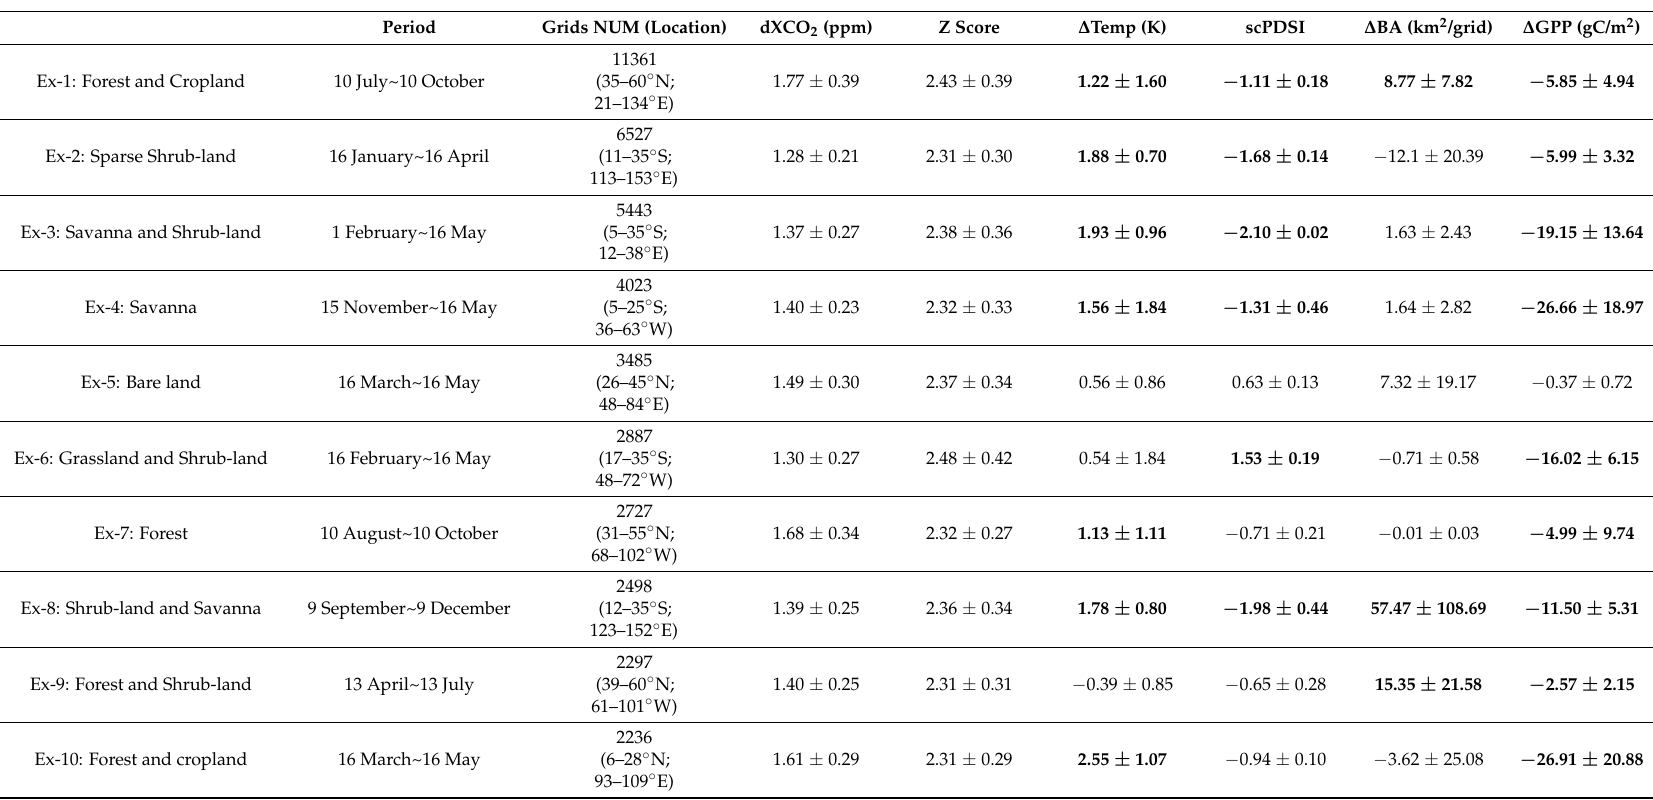
Table 2. Time and space features of detected extreme units (Ex) 1 through 10. Their land over types, period, grids number (NUM), location, dXCO 2 , Z score, and difference between monthly data and its normal value over significant different period about surface skin temperature ( ∆ Temp), self-calibrating Palmer drought severity index (scPDSI) (negative for drought and vice versa), burned area ( ∆ BA) and gross primary production ( ∆ GPP) during the main detected period over these units. Positive values indicate increasing values during the extreme event. Bold items indicate likely contribution to the atmospheric XCO 2 increase, because they represent forcing that likely increases CO 2 flux to the atmosphere. Period Grids NUM (Location) dXCO 2 (ppm) Z Score ∆ Temp (K) scPDSI ∆ BA (km 2 /grid) ∆ GPP (gC/m 2